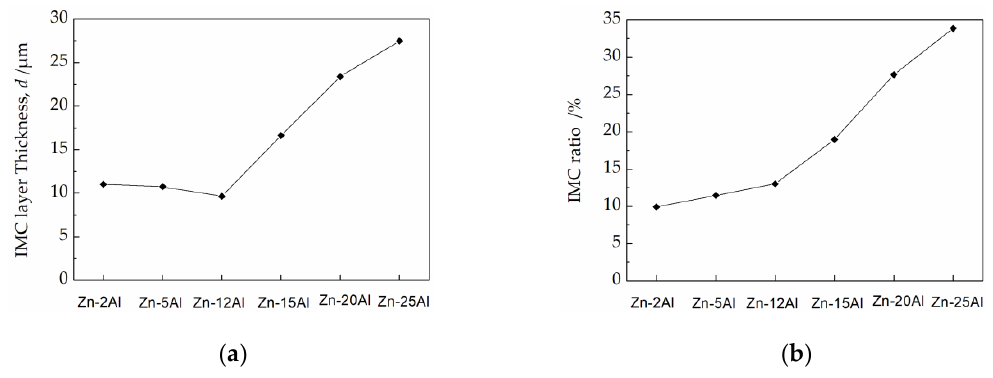
Figure 11. Changes of ( a ) IMC layer thickness and ( b ) bulk IMC ratio in Figure 8.